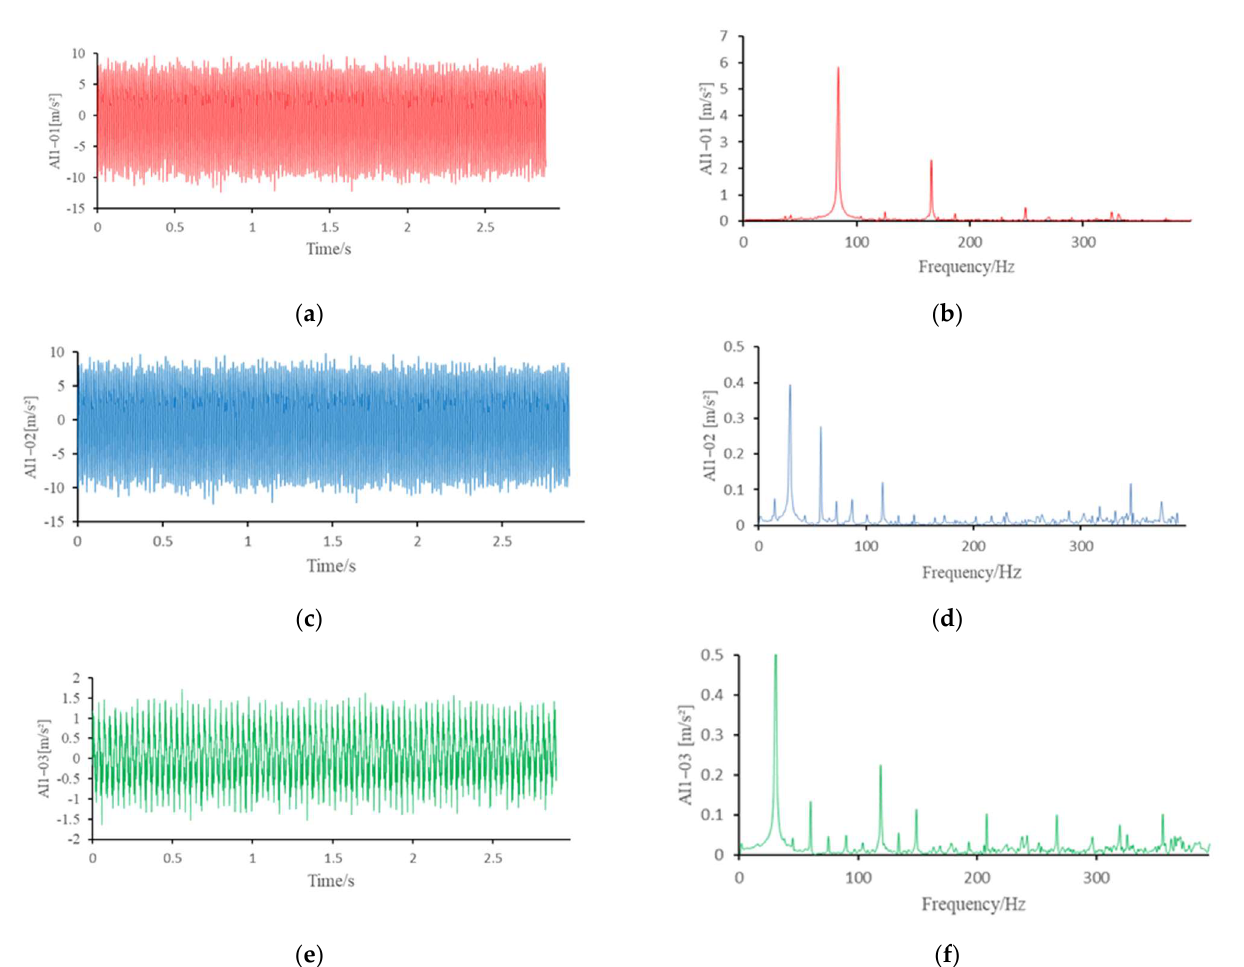
Figure 15. Time and frequency domain diagram of measurement point 1 in X, Y and Z directions. ( a ) is time-domain diagram in the X direction; ( b ) is the frequency domain graph in the X direction; ( c ) is time-domain diagram in the Y direction; ( d ) is frequency-domain graph in the Y direction; ( e ) is time-domain diagram in the Z direction; ( f ) is frequency-domain graph in the Z direction. By analyzing the time domain and frequency spectrum diagrams of point 1, we can see that the amplitude of the time domain curve changes less, and the curve distribution area is more concentrated, which means that the frame has no obvious defects and the overall frame stiffness is more suitable. The frequency spectrum diagram reveals that the frequencies around 30 Hz and 80 Hz are the main frequency components of frame